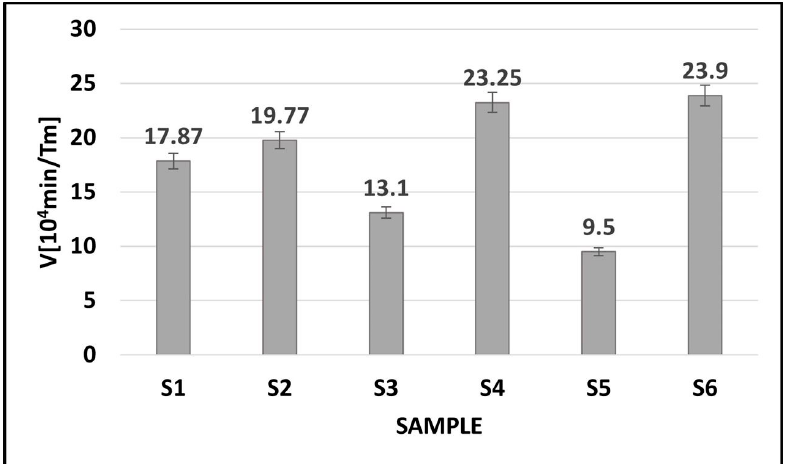
Figure 8. The maximum values of Verdet constants calculated for tellurite glasses.